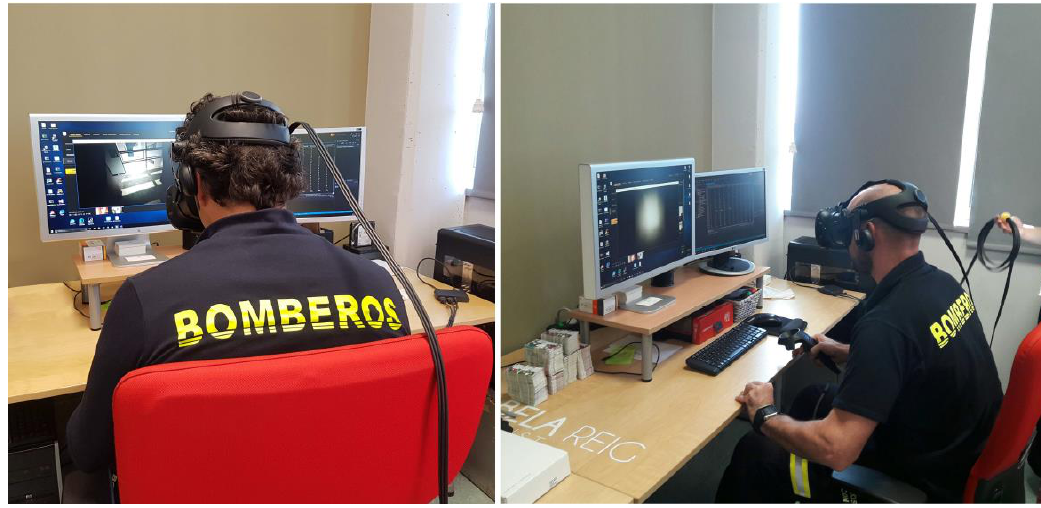
Figure 2. Firefighter tests.